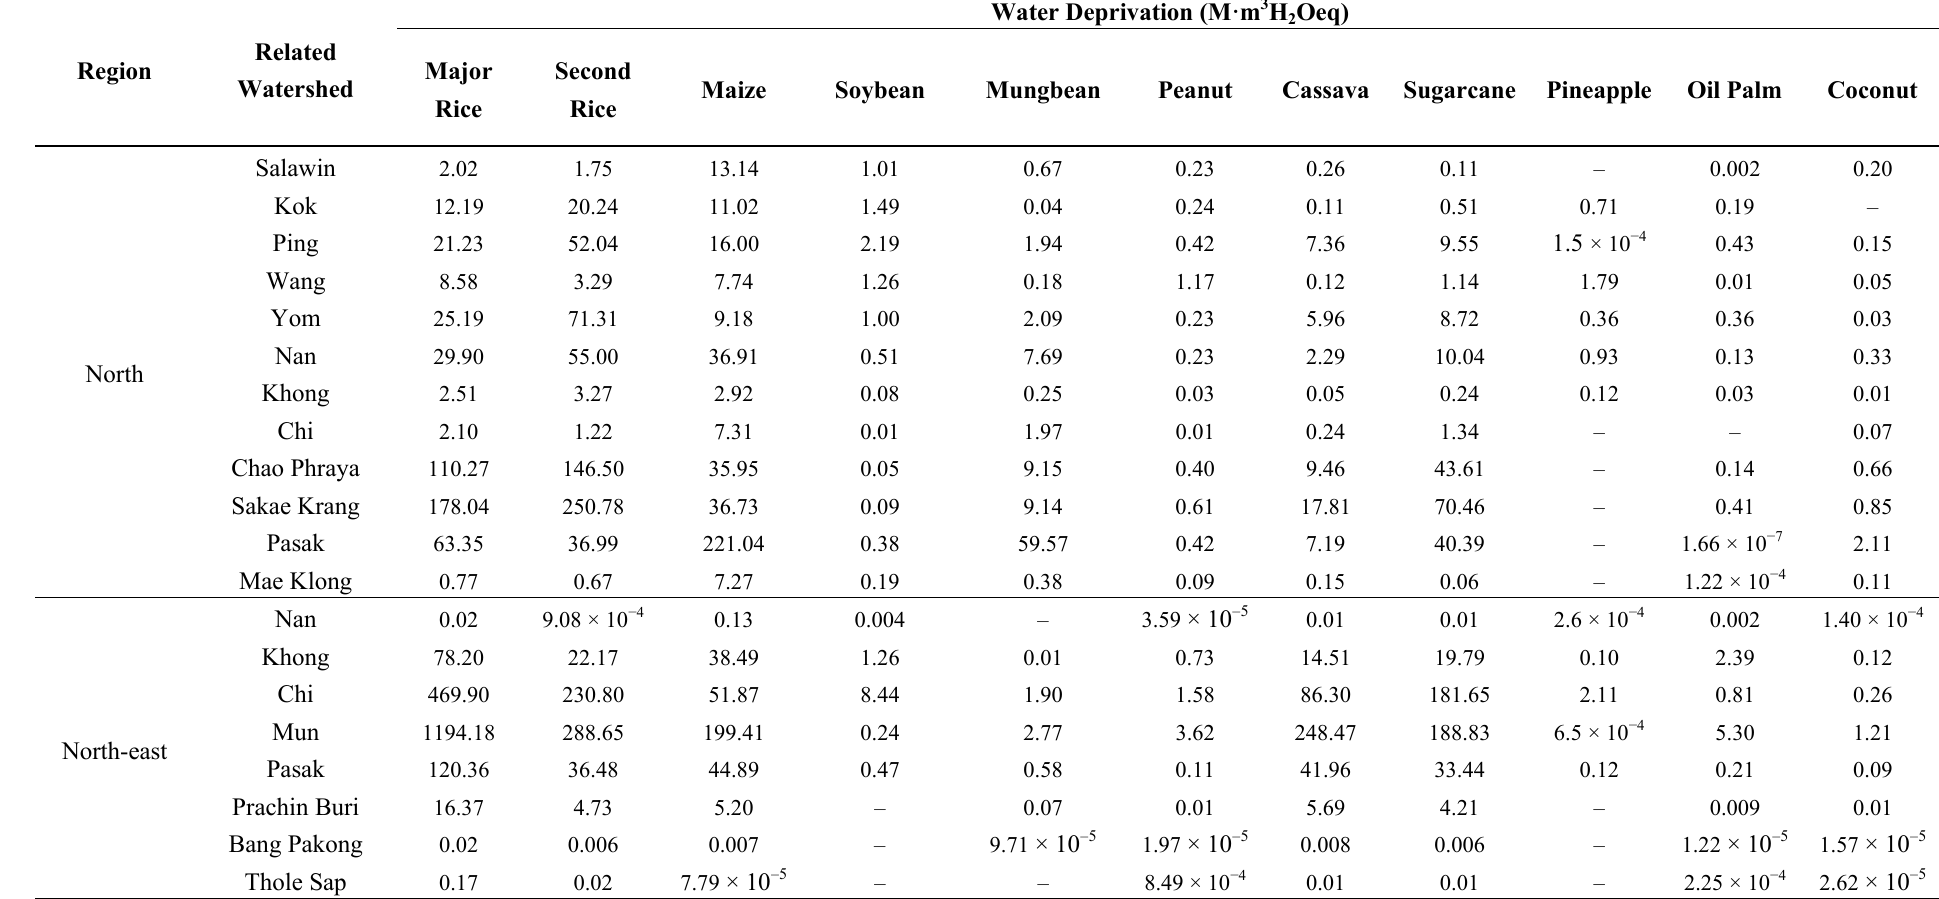
Table 4. Water deprivation of major food, feed, and fuel crops in